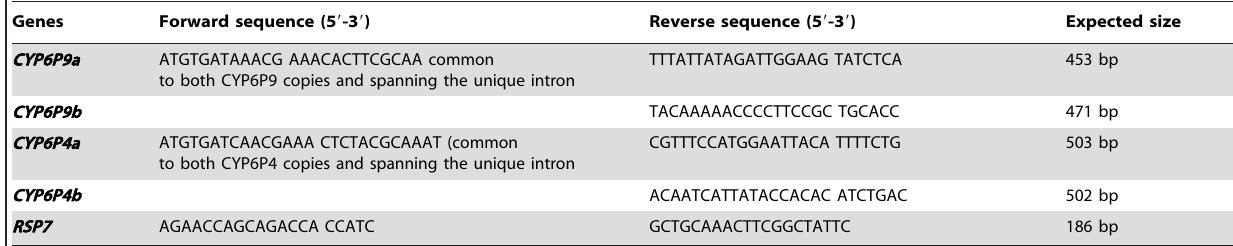
Table 1. Primers used for the RT-PCR.